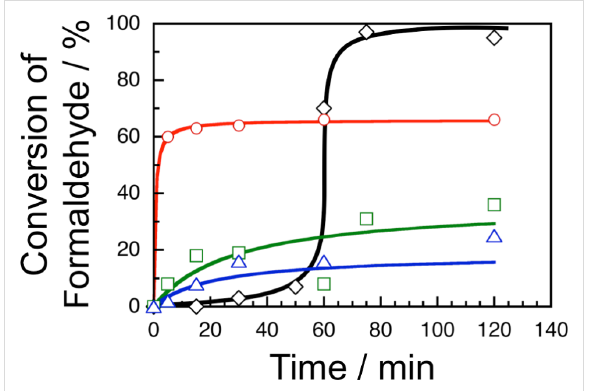
Figure 1: Time–conversion plots for formose reactions in an aqueous solution (black) and in water pools of AOT (red), TX (green), and CTAB reverse micelles (blue) at 60 °C. The curves are drawn as a guide for the